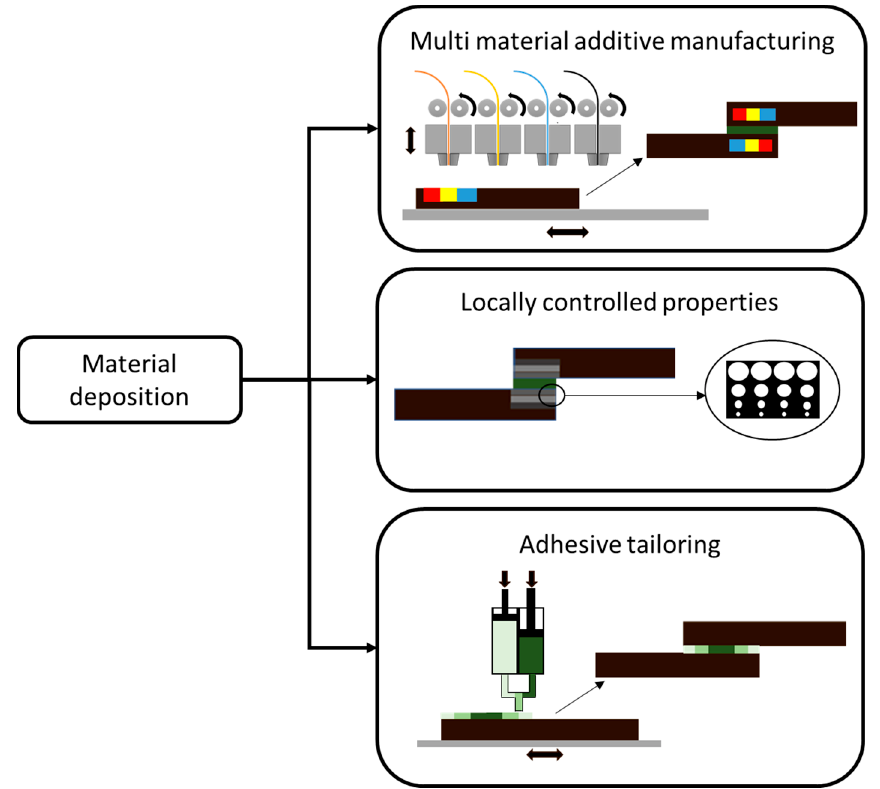
Figure 2. Voxel oriented material deposition design strategies for AM bonded joints.